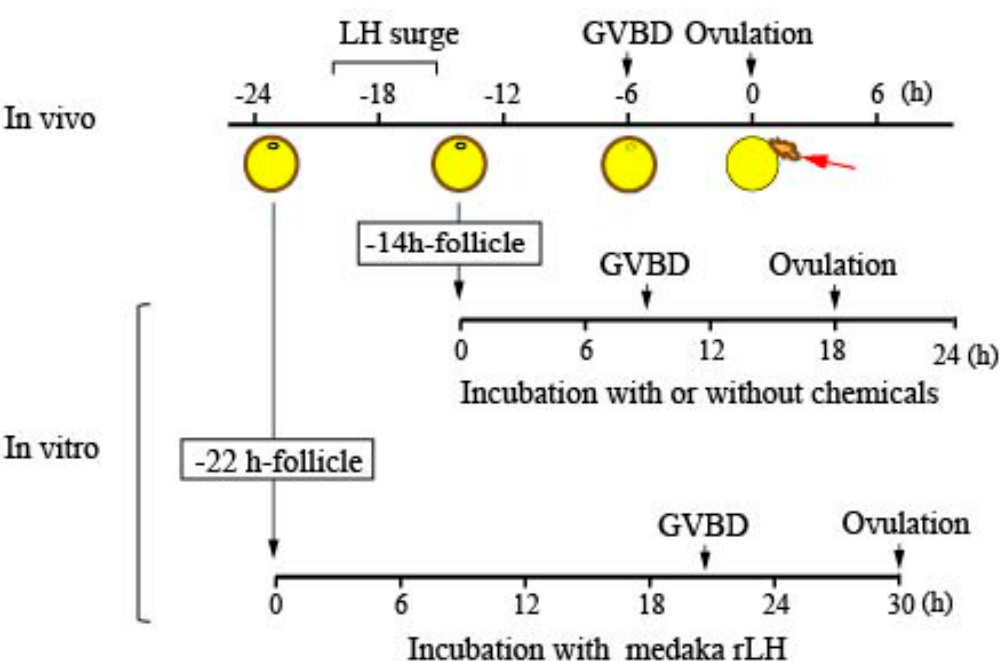
Figure 1. An outline of the in vitro culture experiments using medaka preovulatory follicles. Large follicles destined to ovulate were isolated 22 h before ovulation ( − 22 h-follicle) or 14 h before ovulation ( − 14 h-follicle). The follicles were incubated in medium containing medaka recombinant luteinizing hormone (rLH) (for the − 22 h-follicle) or without LH (for the − 14 h-follicle). Various chemicals were tested in culture using the − 14 h-follicles to assess their effects on ovulation, oocyte maturation, as well as gene and protein expression.